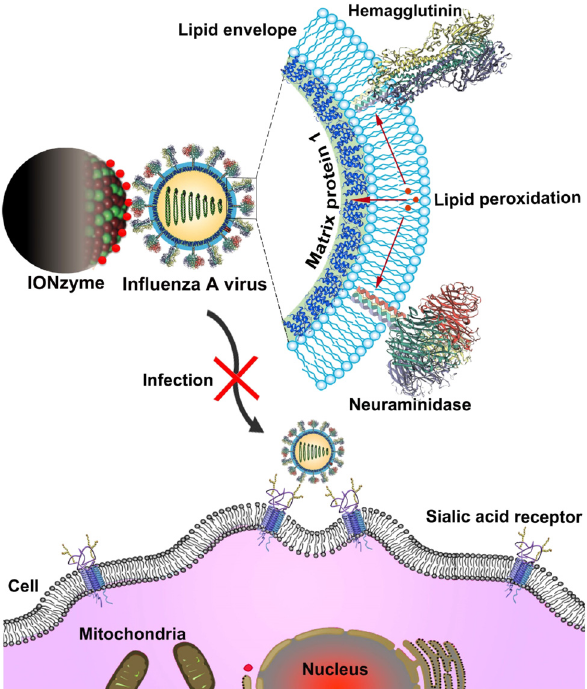
Figure 6: Illustration of viral oxidative breakdown of lipids by iron oxide nanozyme [ 82 ]